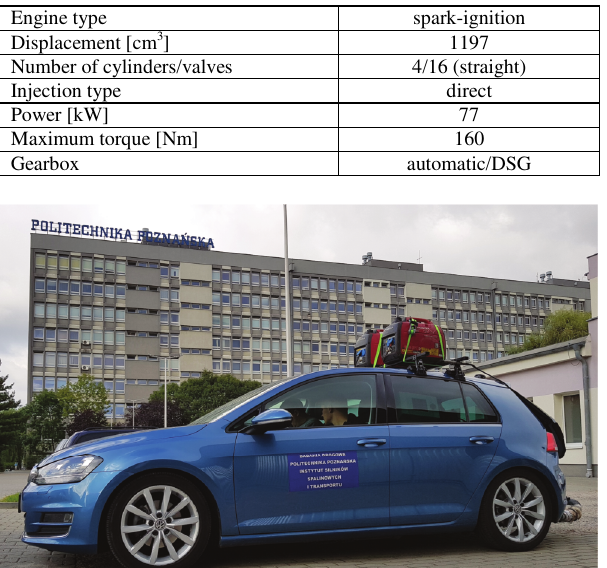
Table 1. Basic engine technical data